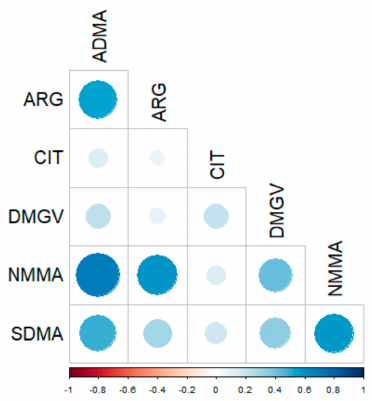
Figure 3. Spearman correlations obtained between methylarginine metabolites (all values, n = 122). ARG, arginine; NNMA, N-mono-methylarginine; CIT, citrulline; ADMA, asymmetric dimethylargi- nine; SDMA, symmetric dimethylarginine; DMGV, dimethylguanidino valerate.